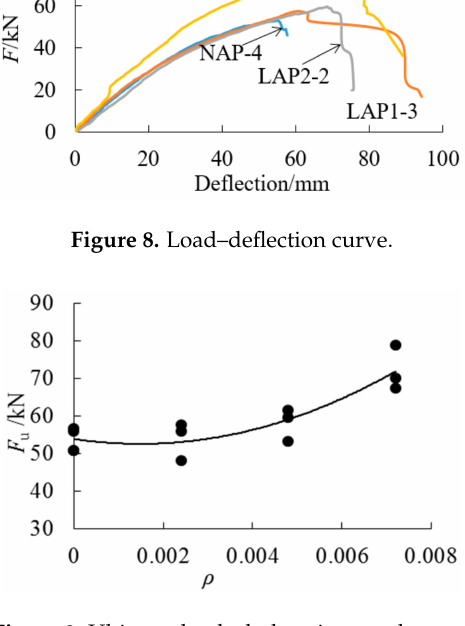
Figure 9. Ultimate load–cloth ratios trend curve.